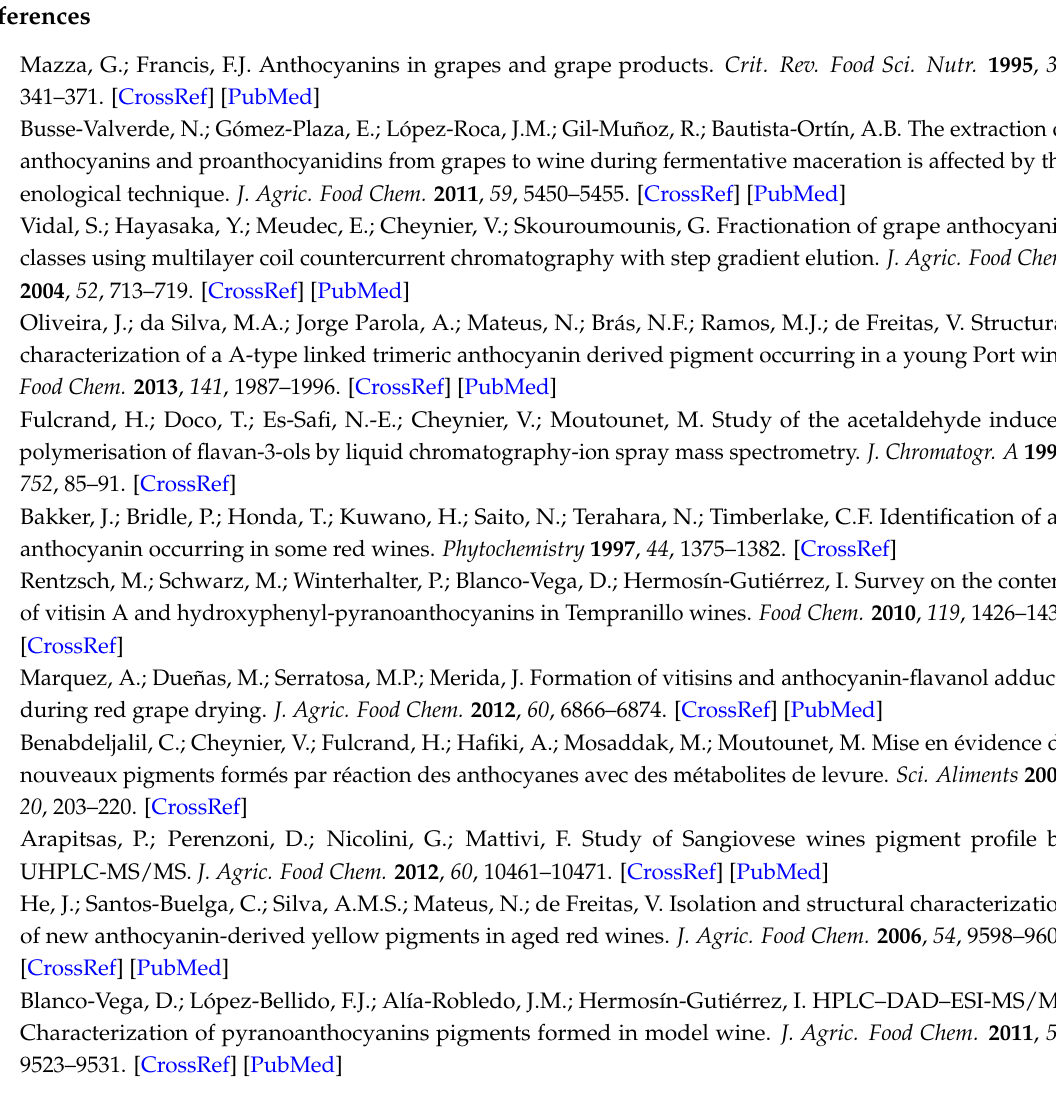
Figure A4. Principal components scree plot.